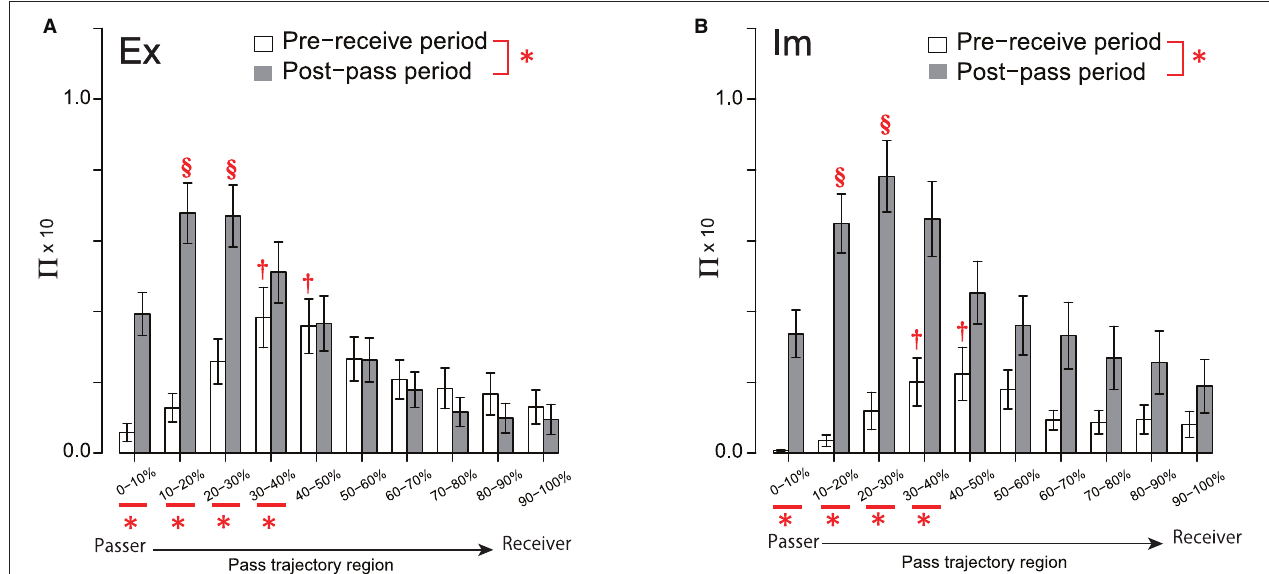
FIGURE 4 | 5 distribution on the pass trajectory for the Ex (A) and Im (B) groups. Significant differences between the two phases and those among the pass-trajectory regions were equivalent for the two groups, because the group had no significant (simple) main effect. Each of the two † in each of the two regions for both groups indicates a significantly higher frequency than those in all other regions, except for the 20%–30% and 50–60% regions. Each of the two § in each of the two regions for both groups indicates significantly higher values than in those of all other regions, except for the 30–40% region. *under the abscissa indicate a significant simple main effect of the group. *bonding two elements of the legends indicate a significant simple main effect of the phase. Level of statistical significance was set to p <